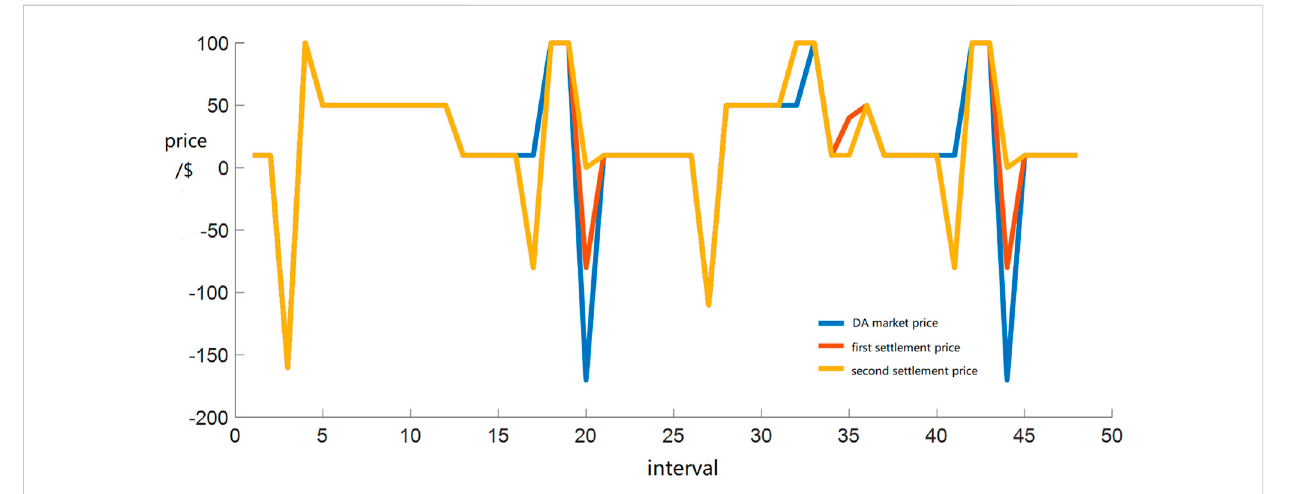
FIGURE 8 Settlement